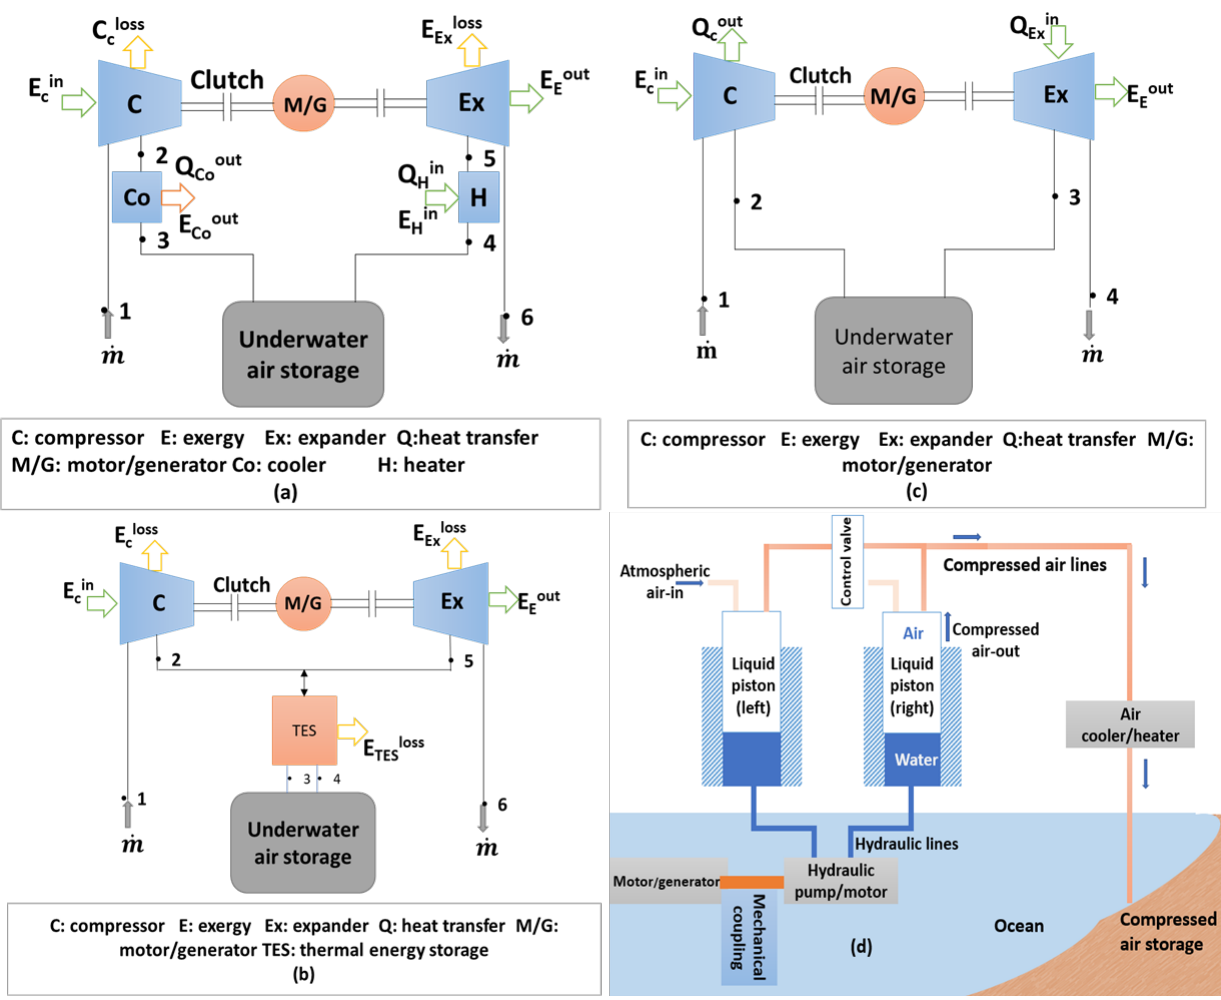
Figure 10. OCAES system: ( a ) diabatic OCAES, ( b ) adiabatic OCAES, ( c ) isothermal OCAES, ( d ) isothermal OCAES system based on the liquid piston concept.